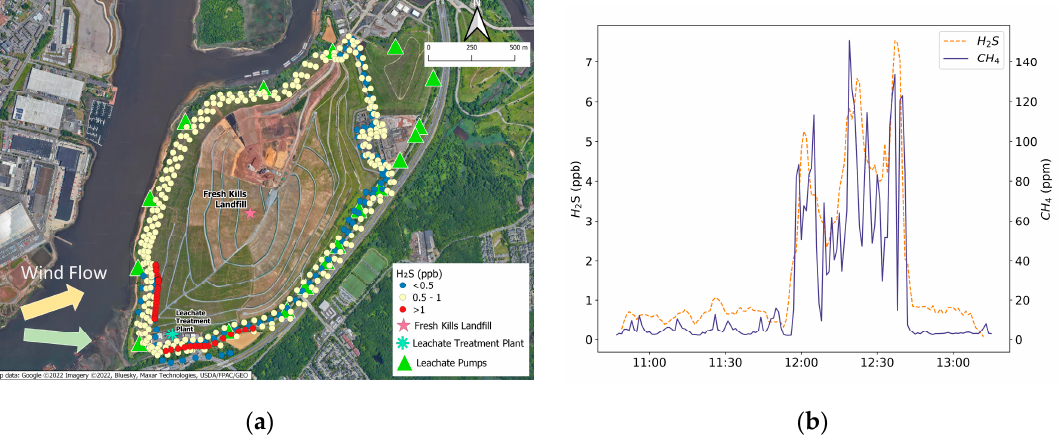
Figure 5. Fresh Kills Day 2, 3 November 2021: ( a ) Aerial image of the loops driven around Fresh Kills and the associated H 2 S measurement MRs, binned and indicated by color. Each loop was slightly offset to the right and below the prior loop to prevent overplotting. The wind flow vectors in the bottom left depict the average wind direction for the first (upper yellow arrow) and the second halves (lower green arrow) of the measurements. ( b ) The 1-minute time-series plot of H 2 S (ppb) and CH 4 (ppm) for the measurement period at Fresh Kills.